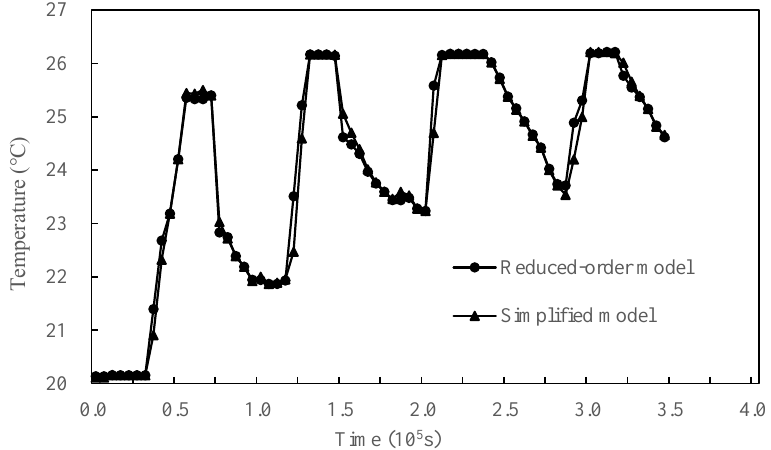
Figure 9. Indoor air temperature between the SM and RM for testing.